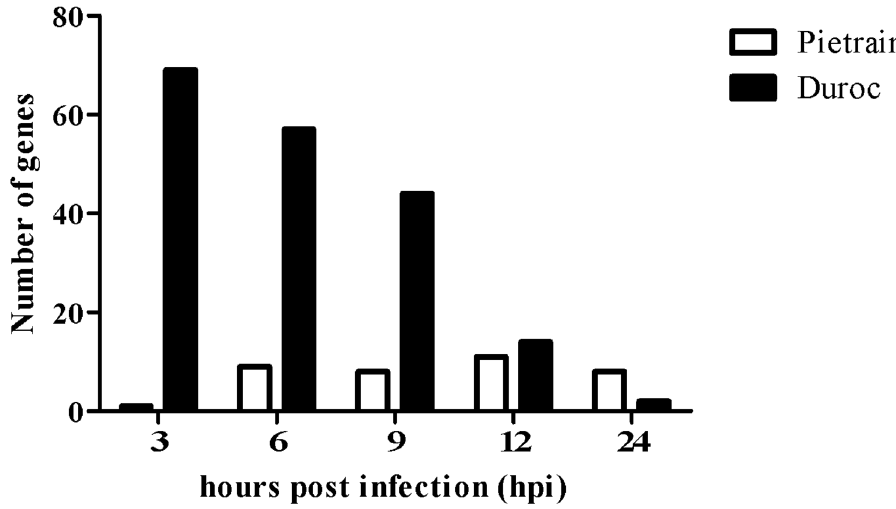
Fig 3. Number of up-regulated genes during the course of PRRSV infection. Pietrain (white bar) and Duroc (black bar) lung DCs at 3, 6, 9, 12, 24 hpi (p (cid:20) 0.05 and FDR (cid:20) 10%).